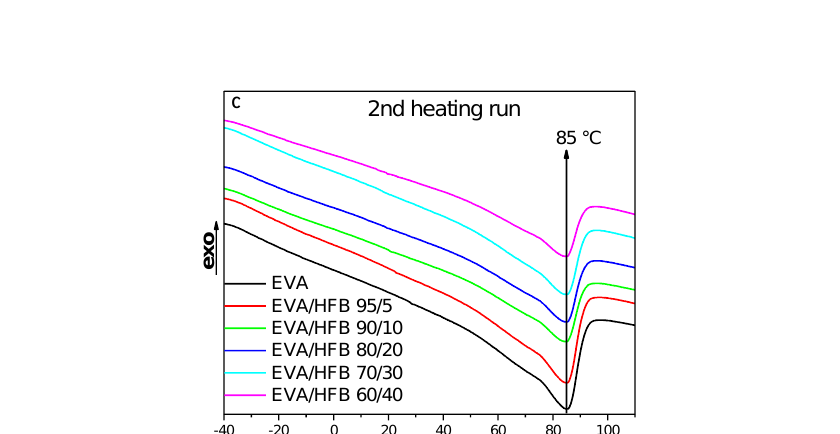
from 120 ◦ C to − 40 ◦ C; and ( C ) second heating run from − 40 ◦ C to 120 ◦ C (heat flow rate: 10 ◦ C/min). from 120 °C to -40 °C; and ( C ) second heating run from -40 °C to 120 °C (heat flow rate: 10 °C/min).